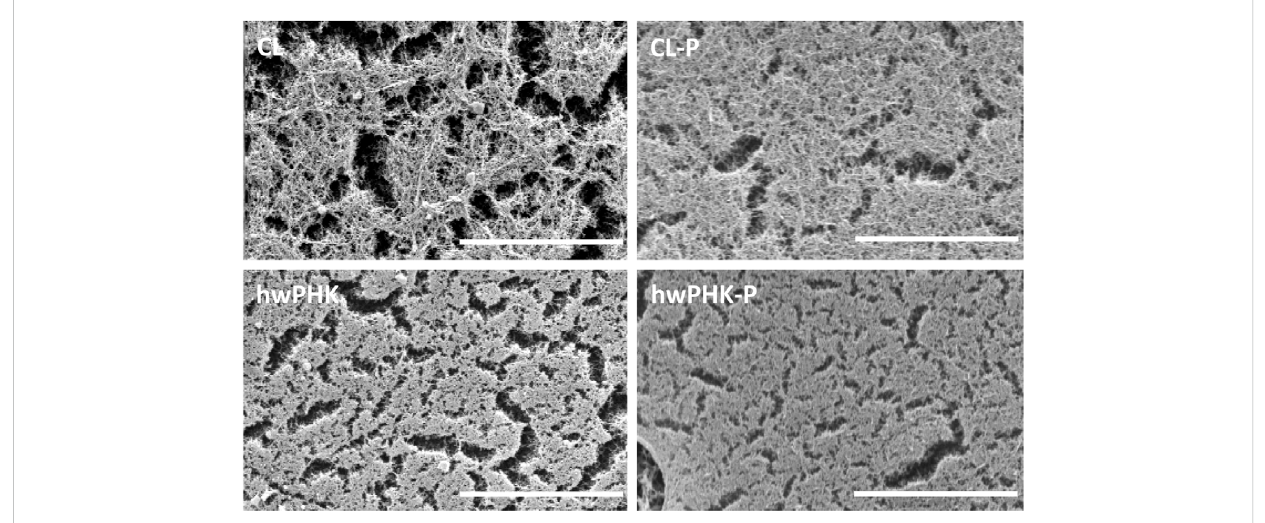
FIGURE 1 SEM photomicrographs of surface of reference and phosphorylated samples prior to hemocompatibility tests. Bar width: 5